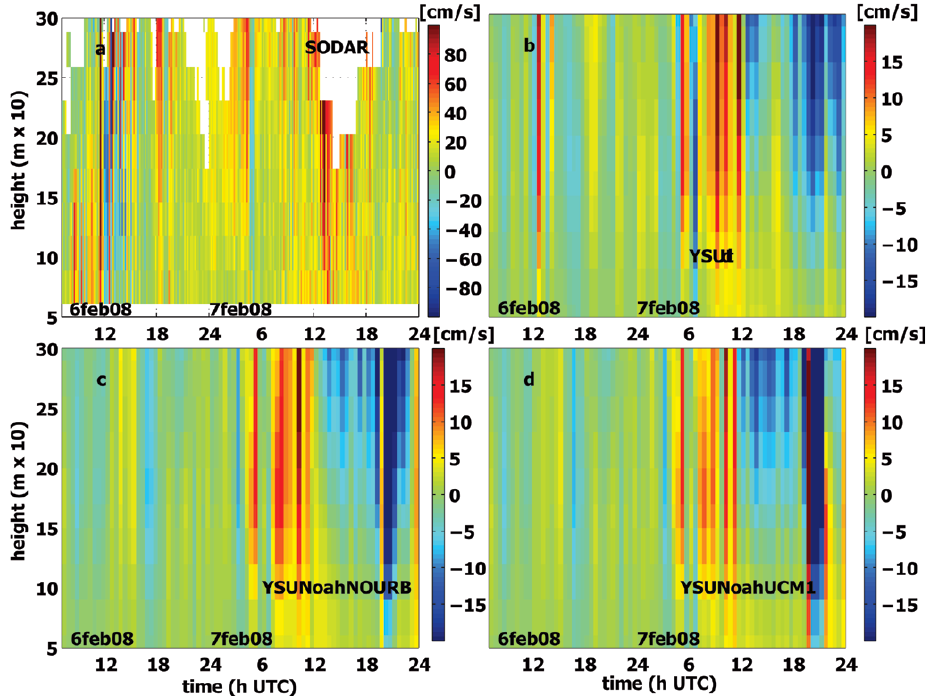
Fig. 10. Time series of the vertical wind speed vertical profile on 6–7 February 2008 for (a) sodar measurements, (b) YSUtd, (c) YSUNoah- NOURB, (d) YSUNoahUCM1. Time is on the x axis and height on the ordinate